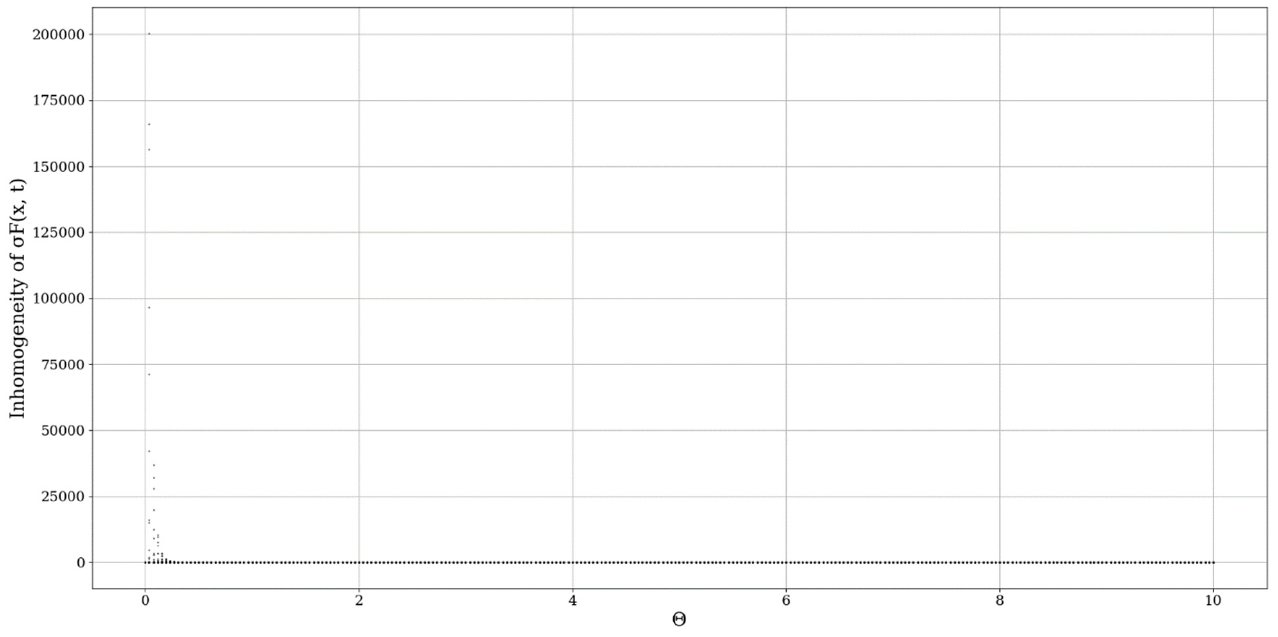
(cid:48) 2 (cid:105) example plot with θ as control parameter; ξ = 6; µ = 1. Figure 7. 〈|σ (cid:2890) (cid:3364)(cid:3364)(cid:3364)| (cid:4593)(cid:2870) 〉 example plot with θ as control parameter; ξ = 6 ; μ = 1 . Figure 7. (cid:104)| σ F |